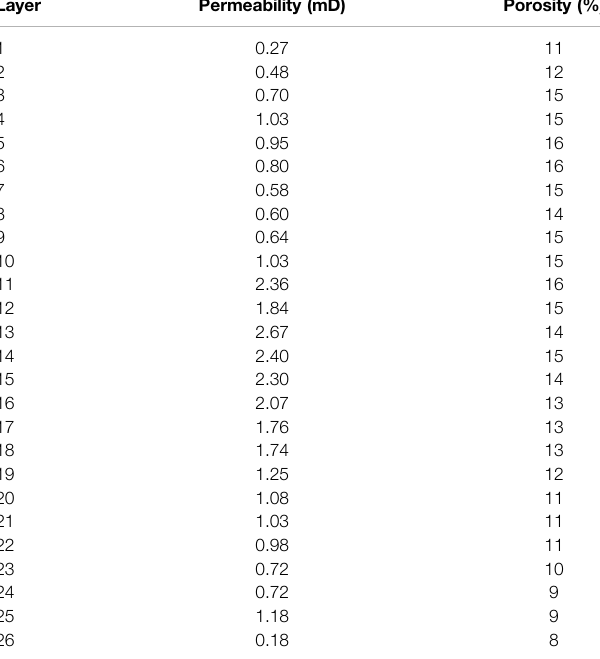
TABLE 1 | Modeled permeability and